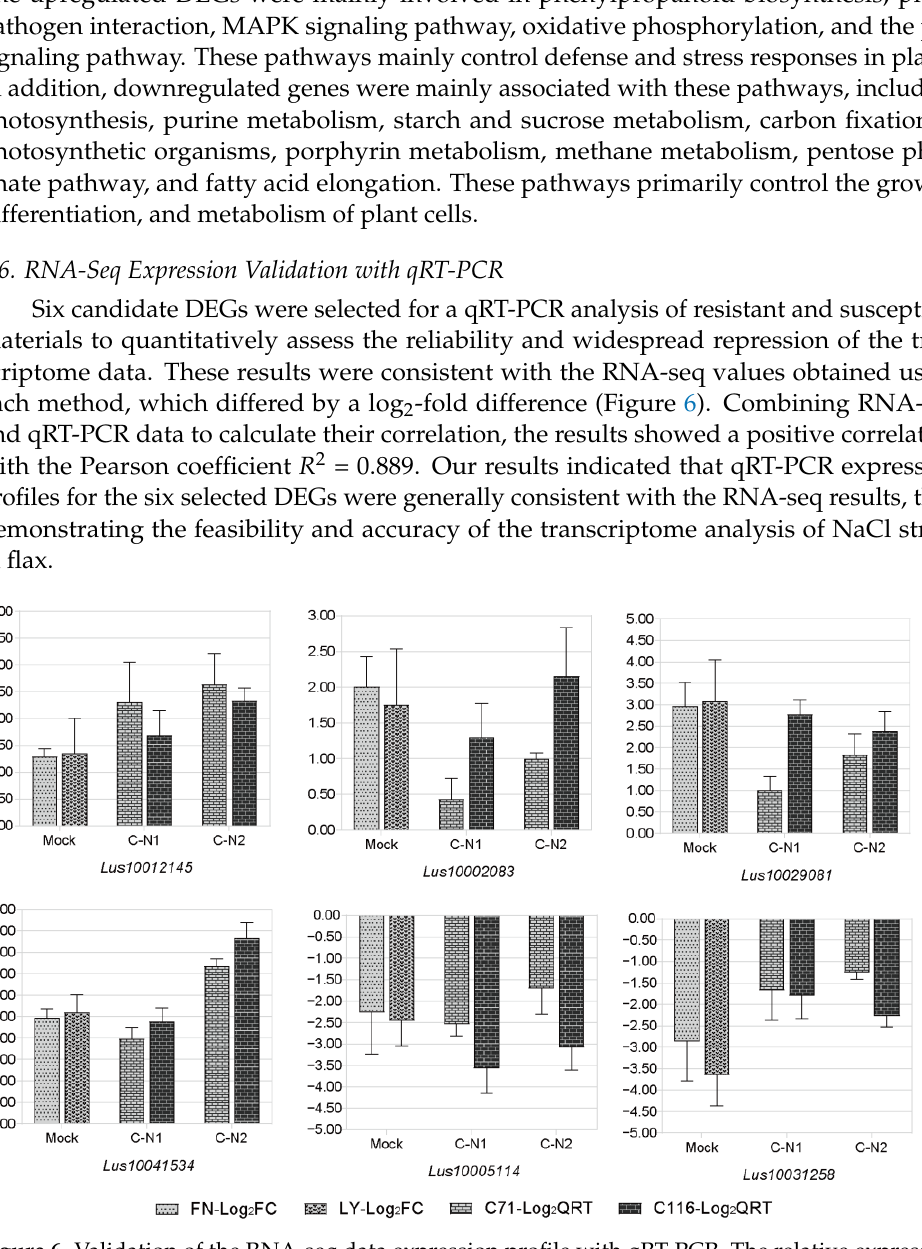
Figure 6. Validation of the RNA-seq data expression profile with qRT-PCR. The relative expression levels of six DEGs were calculated according to the 2 −ΔΔCt method using the Actin gene as an internal reference gene. The x -axis indicates the change of transcriptome data (Mock) and qRT-PCR data after exposure to 200 mM NaCl solution for 24 h (C-N1) and 72 h (C-N2). FN-Log 2 FC, Fanni log 2 (fold change); LY-Log 2 FC, Longya10 log 2 (fold change); C71-Log 2 QRT, C71 log 2 (2 −ΔΔCt ); C116-Log 2 QRT, C116 log 2 (2 −ΔΔCt ).